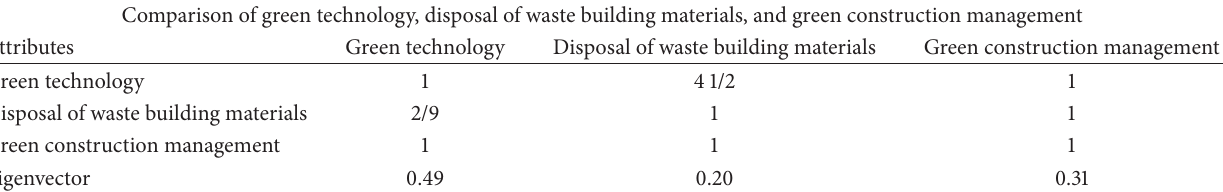
Table 5: Weighting value of construction/management criteria.